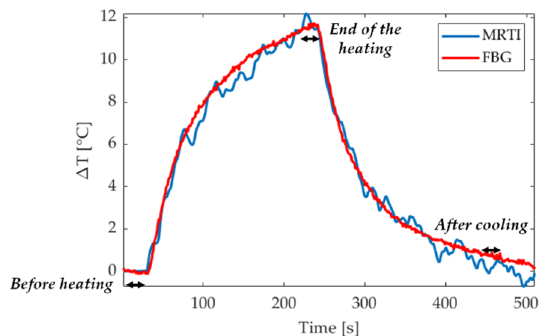
Figure 7. An example of temperature evolution in time for the FBG (blue) and the MRTI (red). These data refer to one out of five different experiments. Time intervals used for the definition of the MRTI precision are also highlighted in the graph with black arrows.